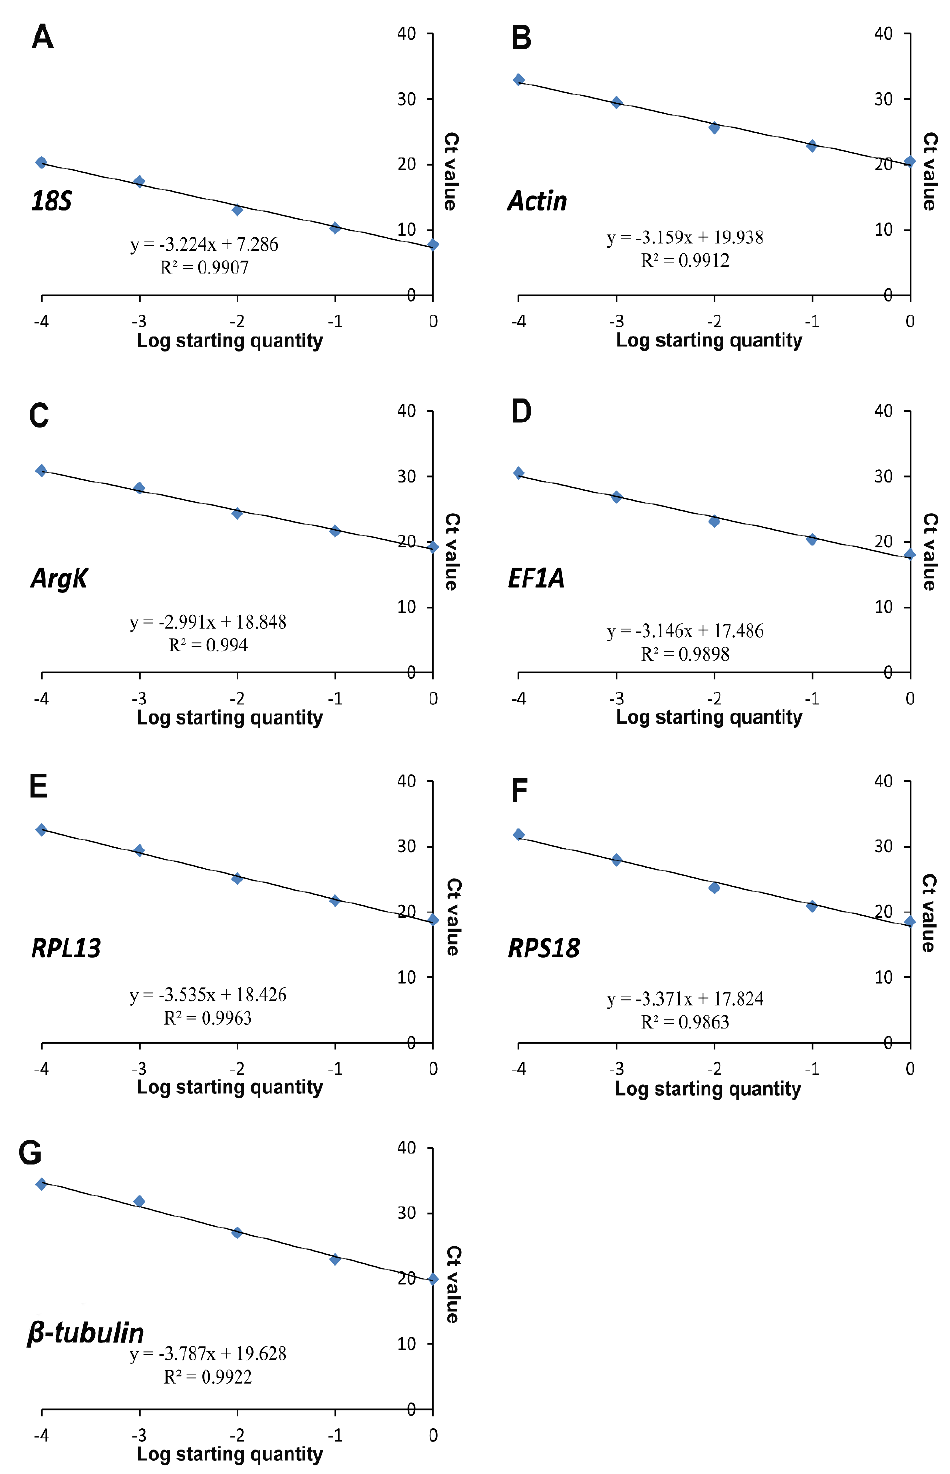
Figure 3. Standard curves of the seven candidate reference genes. ( A ) 18S , ( B ) Actin , ( C ) ArgK , ( D ) EF1A , ( E ) RPL13 , ( F ) RPS18 , and ( G ) β-tubulin .